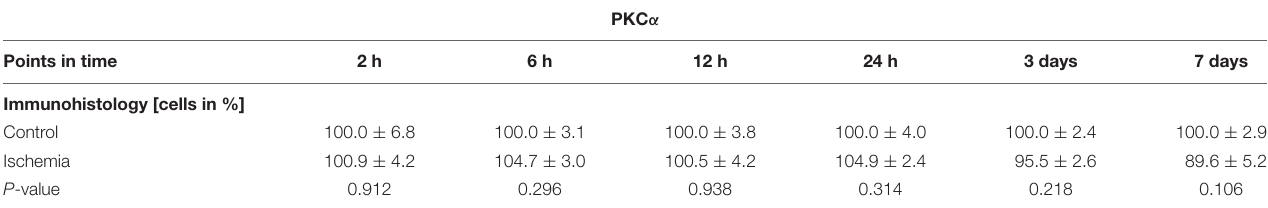
TABLE 6C | Evaluation of the PKC α staining (%) at all points in time.